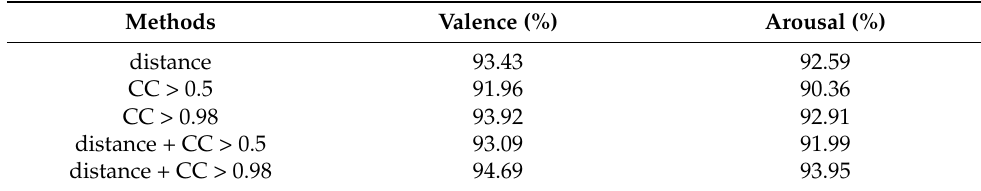
Table 6. Average classification accuracies on all subjects under construction of different adjacency